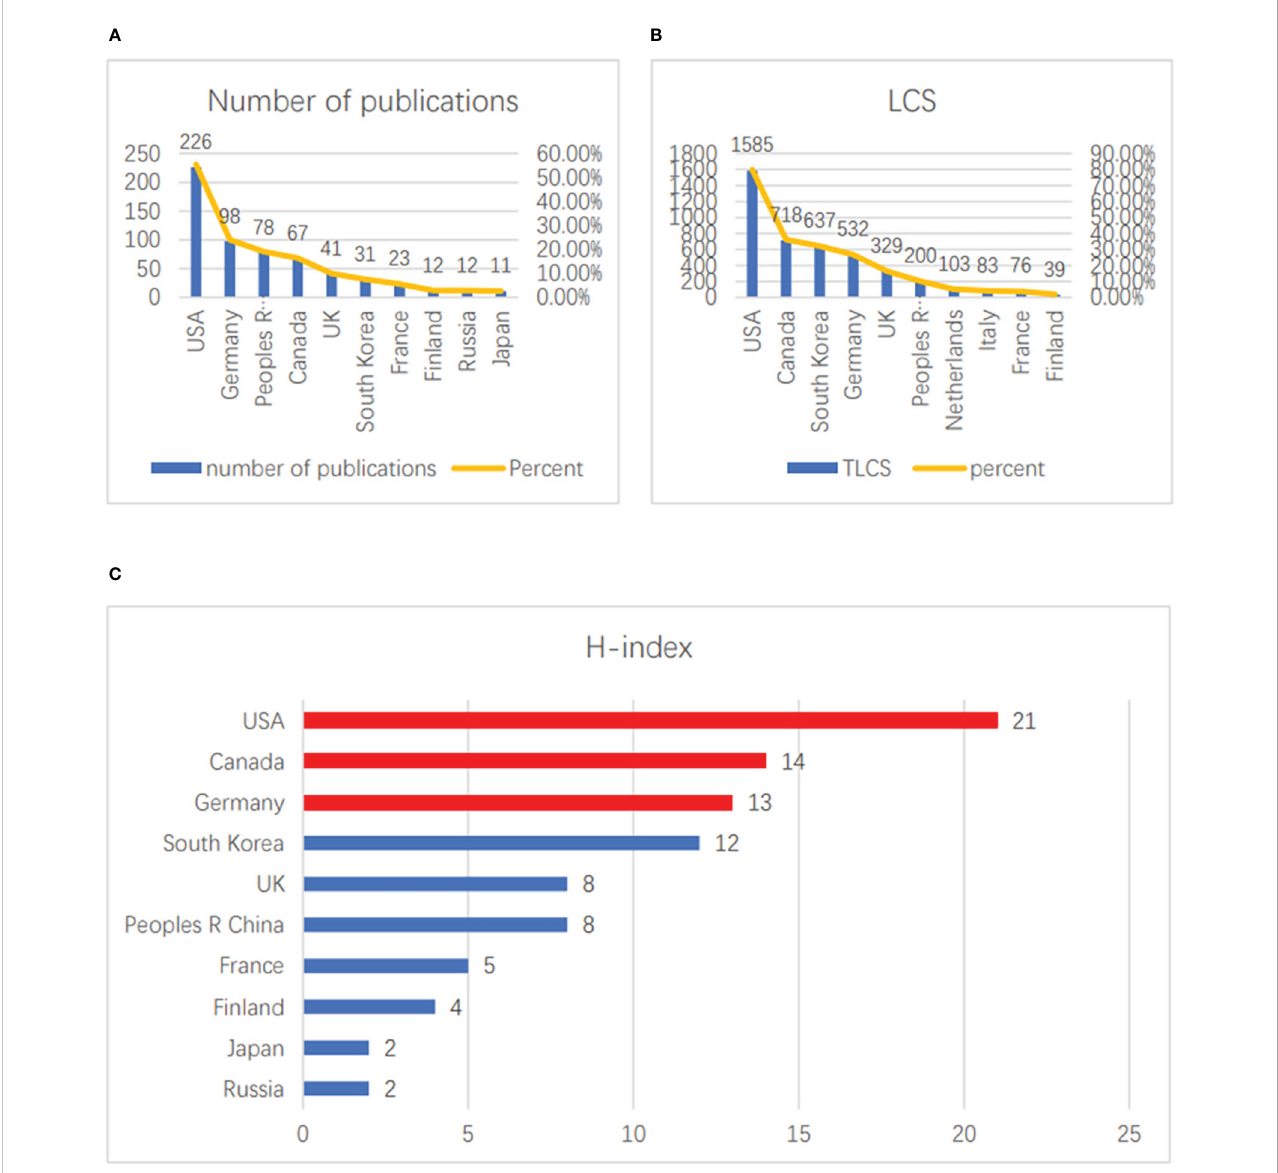
FIGURE 2 Contributions of countries. (A) The top 10 countries with the greatest numbers of publications. (B) The top 10 countries with the greatest numbers of LCS. (C) The top 10 countries with the highest H-index